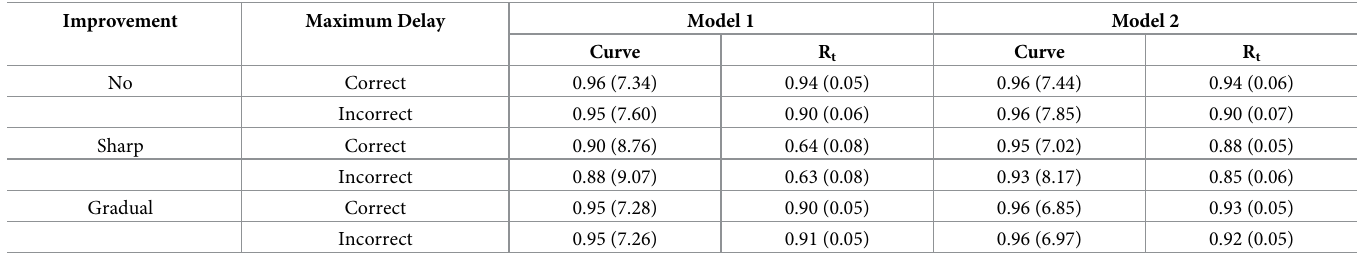
Table 1. Performance measures for complete data. The results were averaged over all simulated datasets and dates for both the epidemic curve (Curve) and the reproduc- ). The results format: coverage rate (RMSE). Model 1 refers to the model in Eq (1) and model 2 refers to the model in Eq tion numbers ( R t